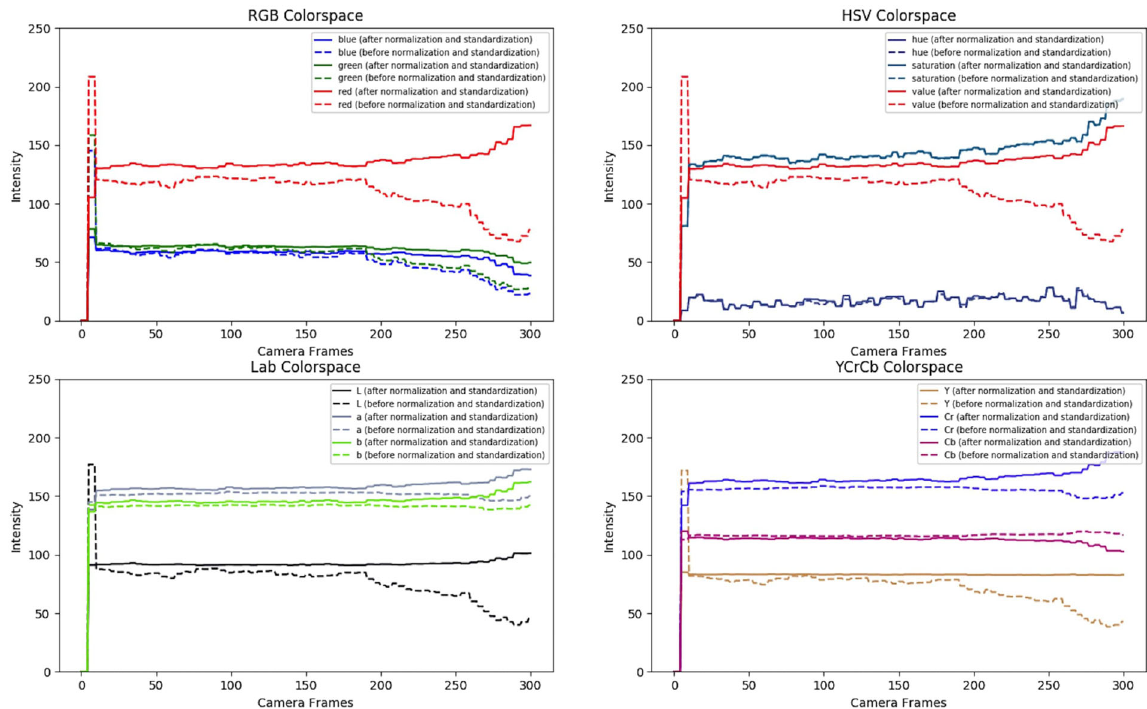
Fig. 7 Comparison of 10 s time window pixel intensities in various color spaces after and before normalization for a random subject. Pixel intensities after normalization are denoted by solid lines and pixel intensities before normalization are denoted by dashed lines. Variation of pixel intensities in individual components of the RGB (top left), HSV (top right), LAB (bottom left) and YCrCb (bottom right) color spaces are